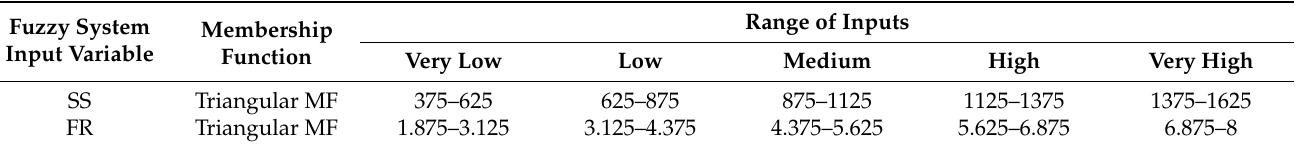
Figure 15. Fuzzification of FSSW strength fuzzy system inputs. Table 11. Membership functions of FSSW strength fuzzy system